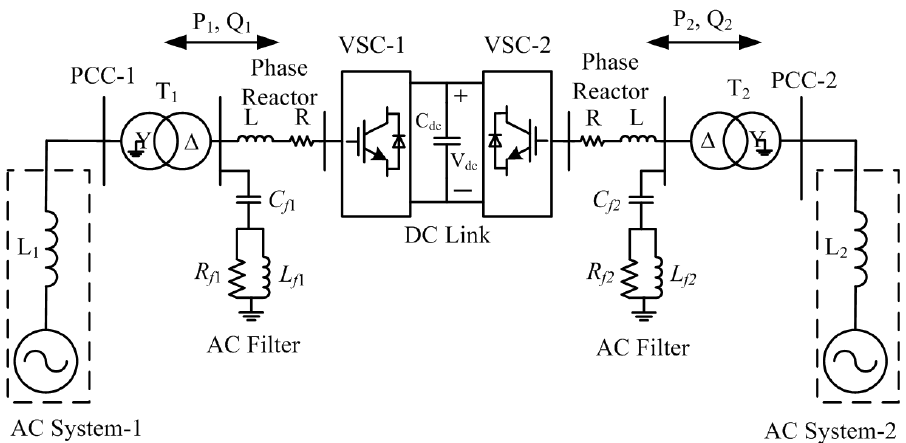
Figure 10. A BTB VSC-HVDC system interconnecting two AC power